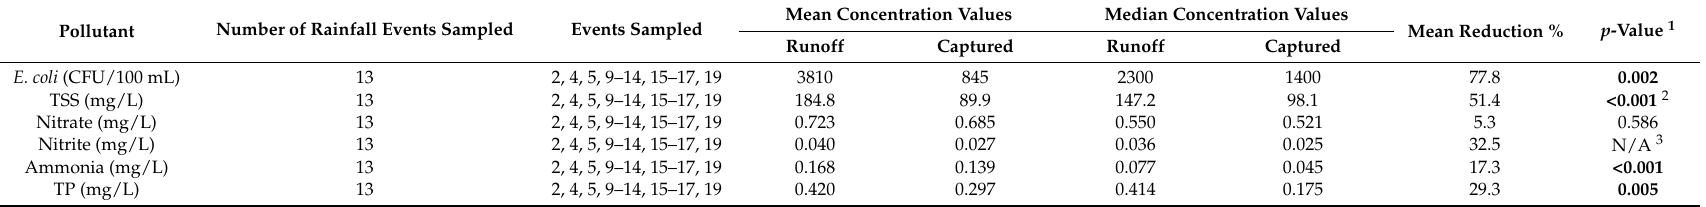
Table 6. Measured pollutant concentrations and observed mean reductions, GI 17H (shaft